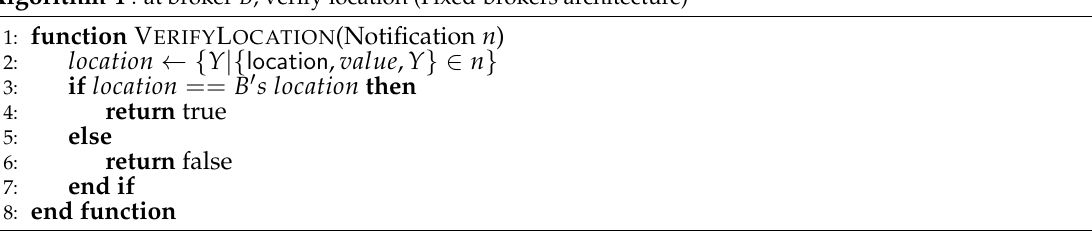
Algorithm 4 : at broker B , verify location (Fixed-brokers